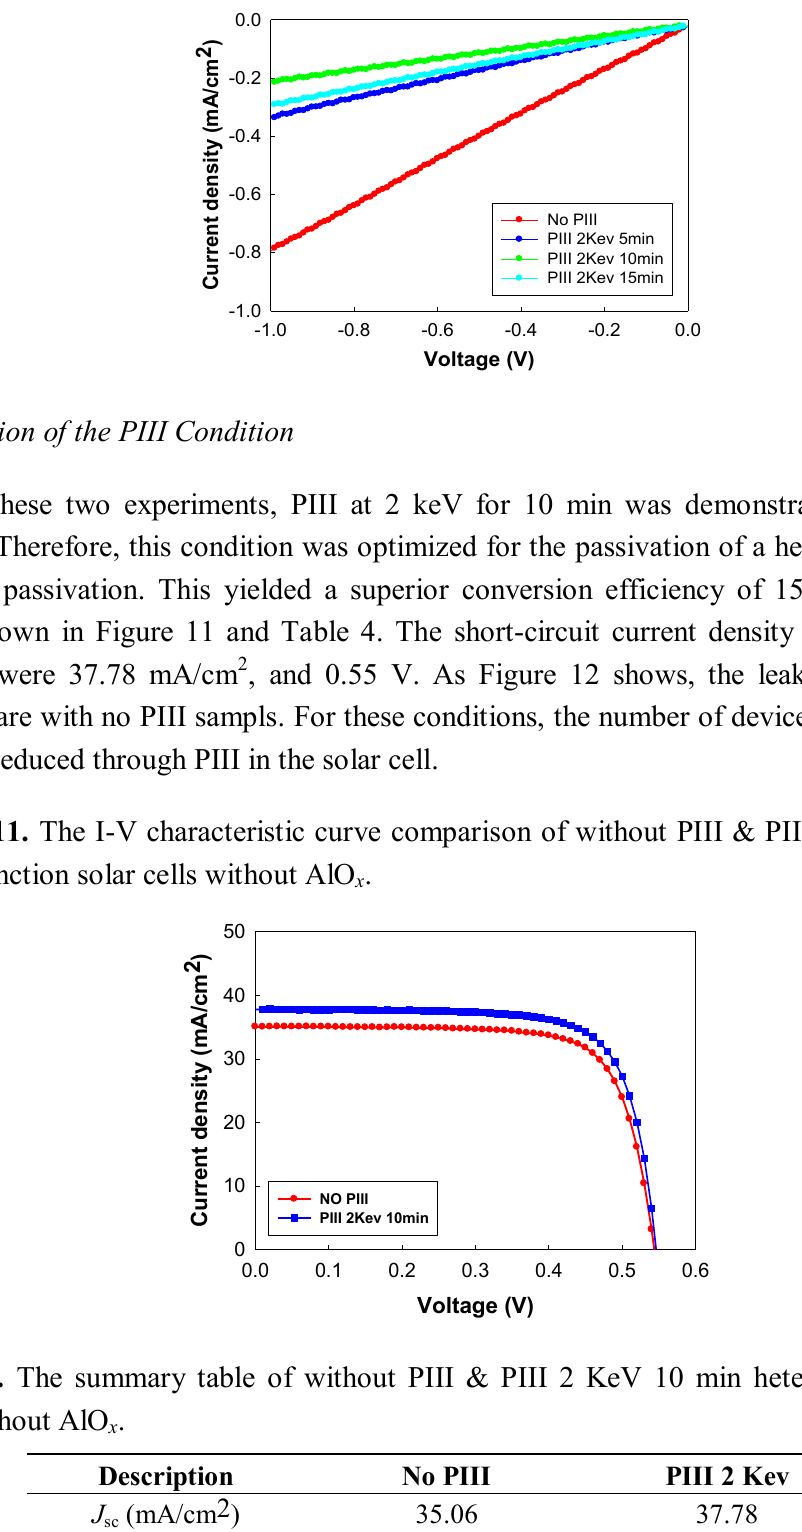
Figure 10. The reverse dark I-V characteristic curve of solar cell (using homojunction solar cell with AlO passivation). x